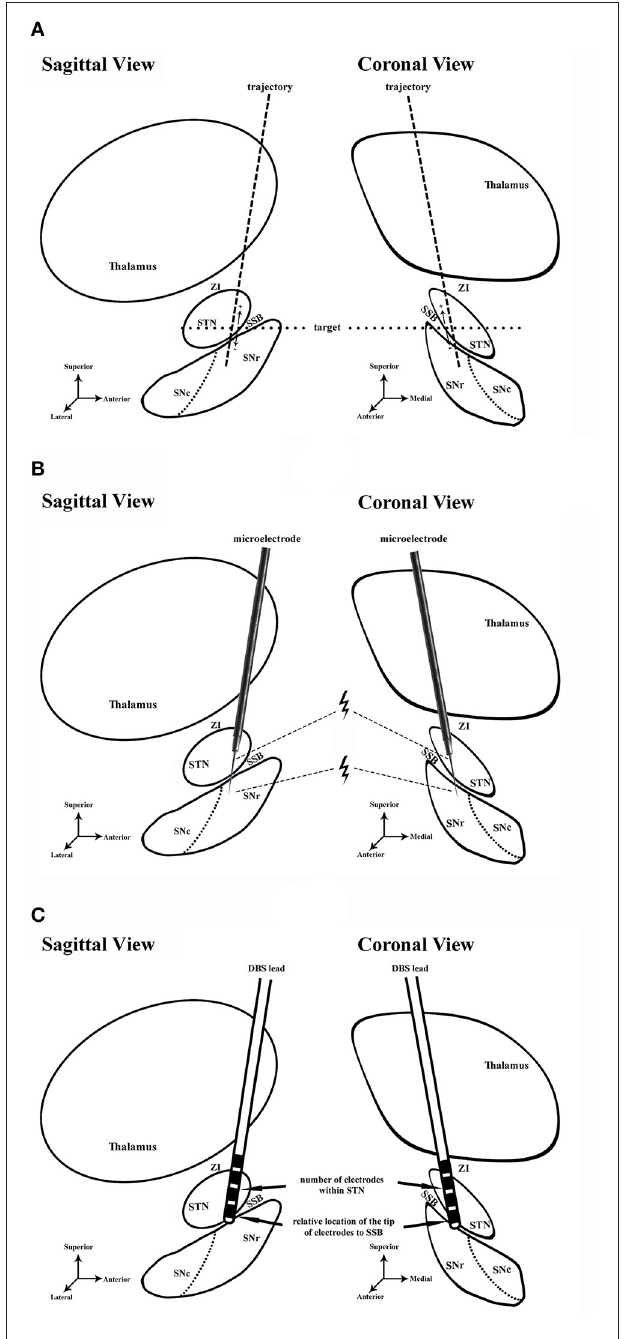
FIGURE 1 | Schematic diagram of the study. (A) Preoperative planning in sagittal and coronal views. Dash line, trajectory of lead placement. Dot line, the level of target. (B) Microelectrode recording and microstimulation during the DBS surgery. Microstimulation was conducted in the ventral STN and dorsal SNr. Thunder symbol, microstimulation near the exit of STN and entrance of SNr. (C) Assessment of lead placement. The number of electrodes in STN (arrow) and the relative location of the electrode tip to SSB (arrow) were assessed to evaluate the lead placement. STN, subthalamic nucleus; ZI, zona incerta; SNr, substantia nigra pars reticulata; SNc, substantia nigra pars compacta; SSB, boundary between subthalamic nucleus and substantia nigra; DBS, deep brain